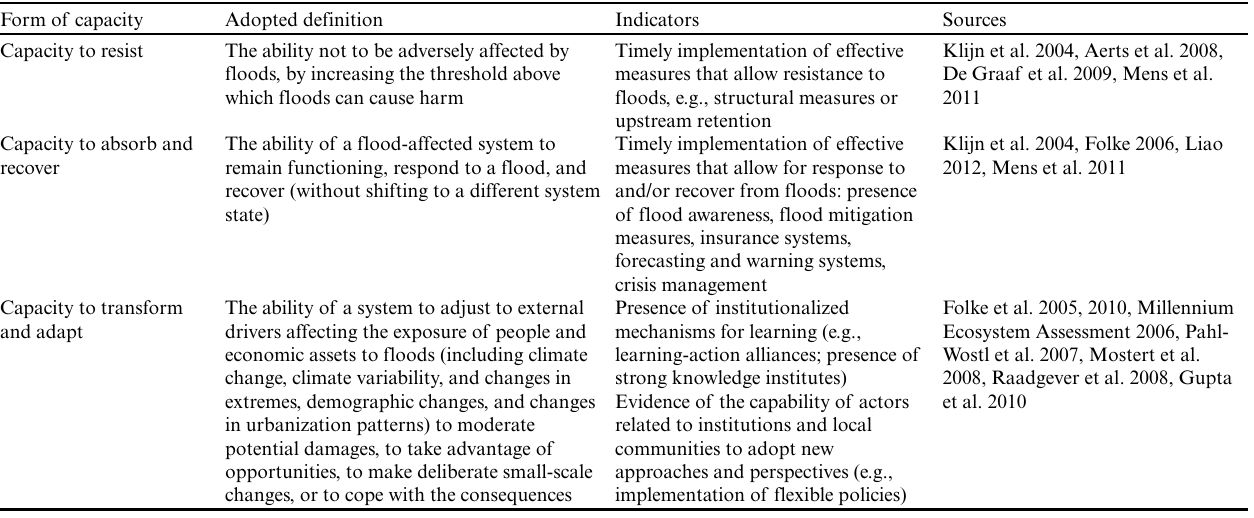
Table 2 . Three capacities of resilience in application to floods: definitions, indicators, and